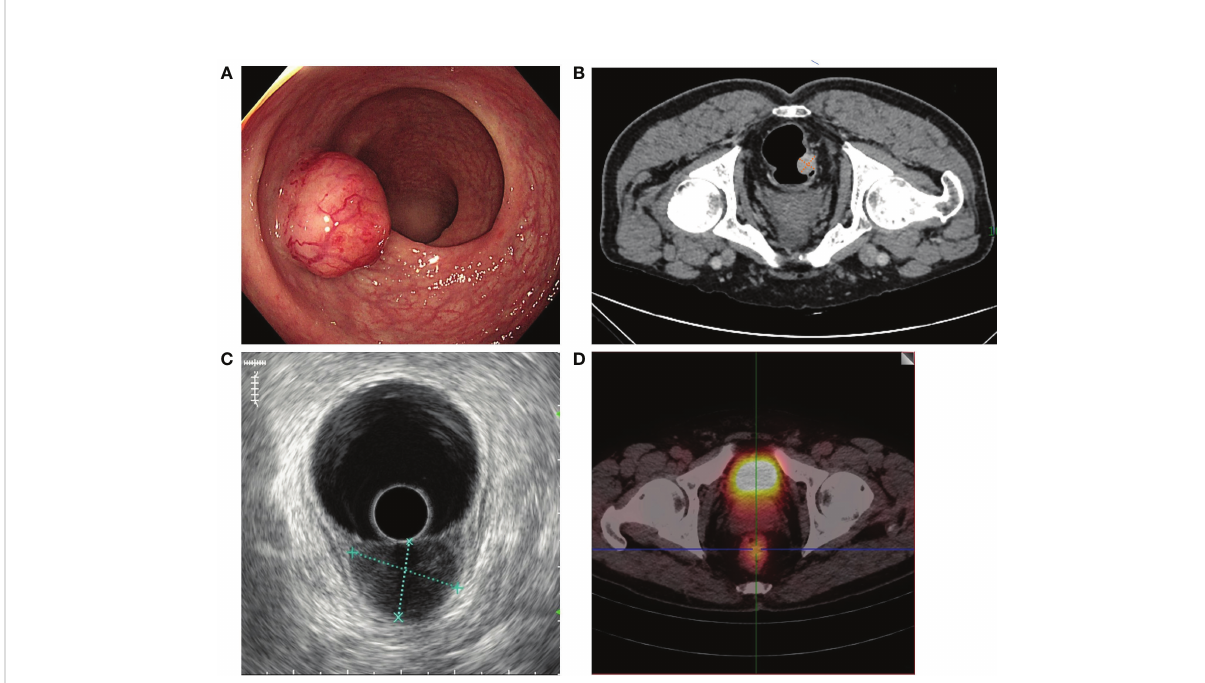
FIGURE 1 Preoperative endoscopic and imaging examination results. (A) Colonoscopy revealed the tumor was 2.4 cm × 2.0 cm in diameter in the lower rectum with a wide stratum. (B) CT revealed no LLNs enlargement in the mesorectum and on both sides of the lateral pelvic space. (C) The EUS reveals the lesion invades the submucosal layer and no LLNM. (D) 99 Tc m -octreotide SPECT revealed high uptake in the rectal cavity and no uptake in either side of the lateral pelvic